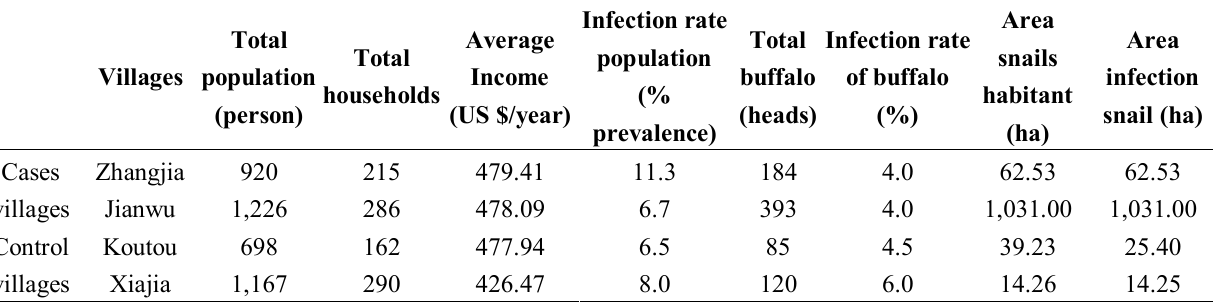
Table 1. Baseline information for the four